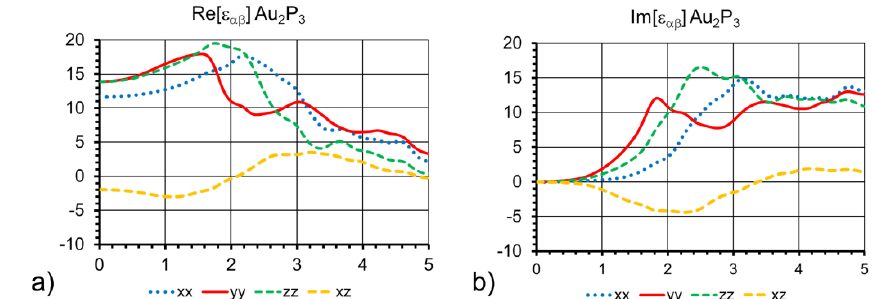
Figure 5. ( a ) Real and imaginary ( b ) parts of the dielectric function from HSE06+scGW0 ab-initio calculations. The three diagonal components and the off-diagonal component in the (a,b)-plane are shown.